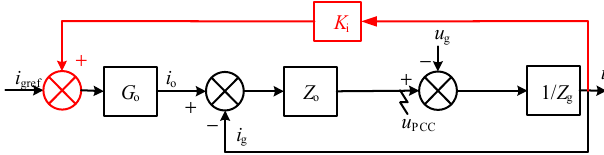
Figure 6. The structure of grid current feedback control.